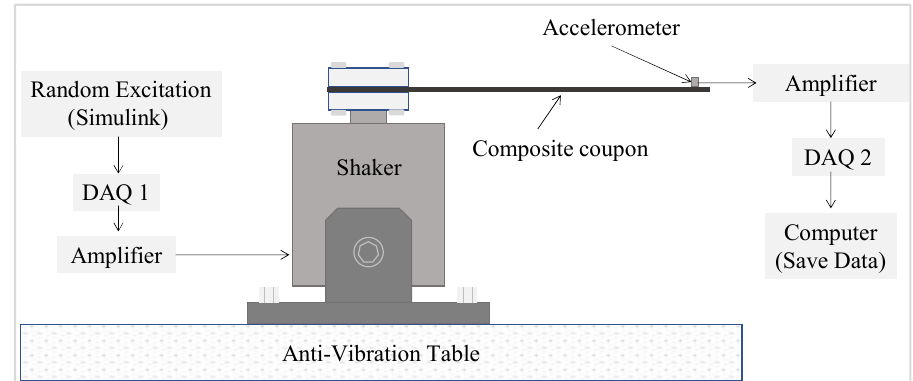
Figure 5. Experimental workflow for vibration testing of composite samples.